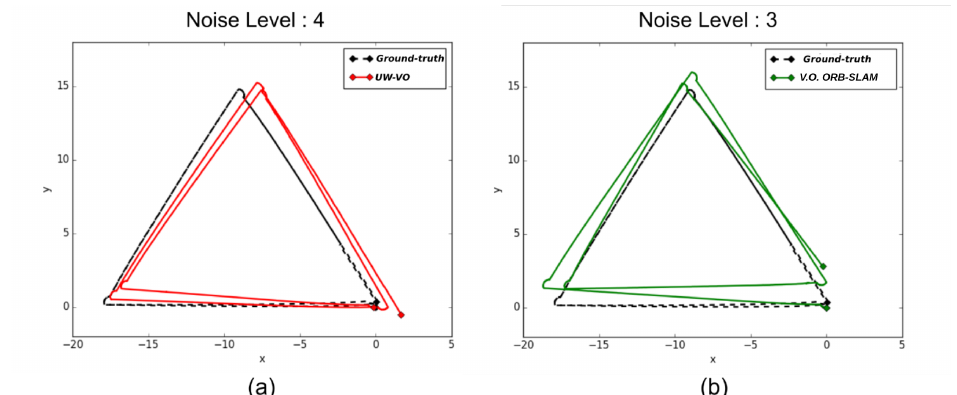
Figure 8. Trajectories estimated with ( a ) our method on the sequence with the highest level of noise and with ( b ) V.O. ORB-SLAM on the sequence with the noise level of